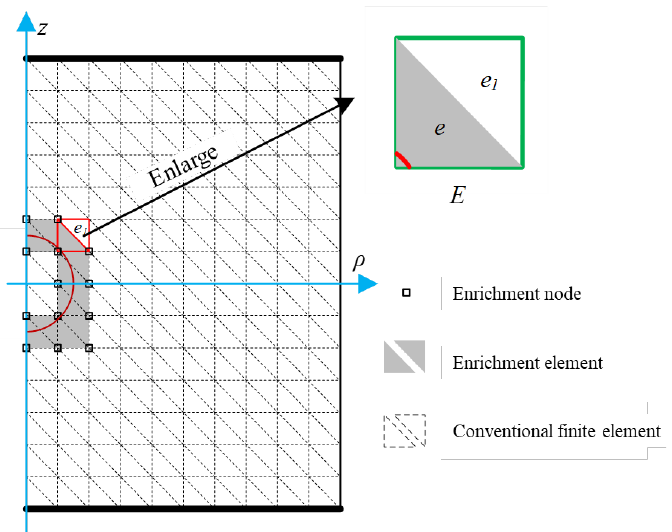
Figure 1. Axisymmetric analysis model from three-dimensional field domain. Figure 2 represents a sphere located in the middle of a cylinder. The elements con- taining the interface are called the enrichment elements as E . The nodes related to the enrichment elements are named enrichment nodes.